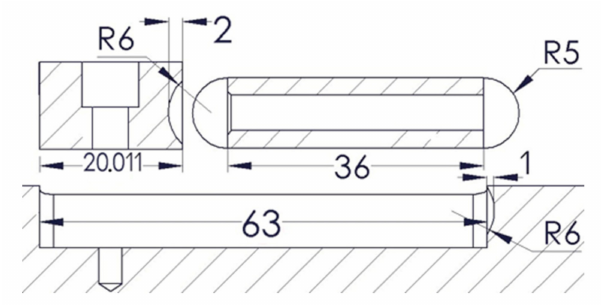
Figure 14. Slots